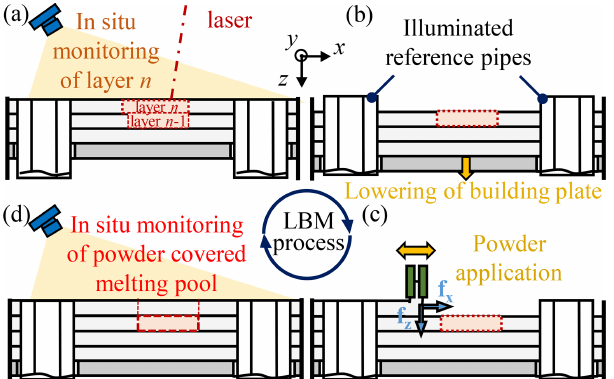
Figure 3. Process flow of LBM: (a) energy input of the laser and subsequent in situ monitoring of referenced melting pool, (b) low- ering of the building plate, (c) powder application, and (d) in situ monitoring of the powder-covered melting pool.